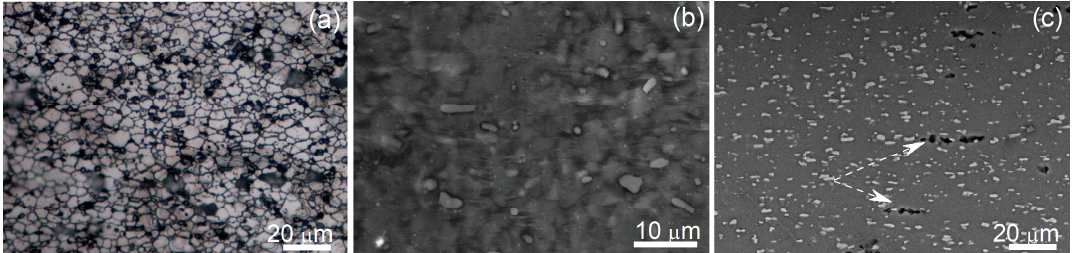
Figure 3. Microstructures after superplastic deformation: ( a ) LM image of the grain structure after failure at 420 °C and 0.02 s − 1 ; ( b ) SEM image of the deformed at 0.02 s − 1 and 440 °C to strain of 0.69 pre-polished surface; ( c ) SEM microstructure after failure at e = 2.2 at a strain rate of 0.02 s − 1 at 440 °C; the white arrows indicate cavities; the tensile direction is horizontal.